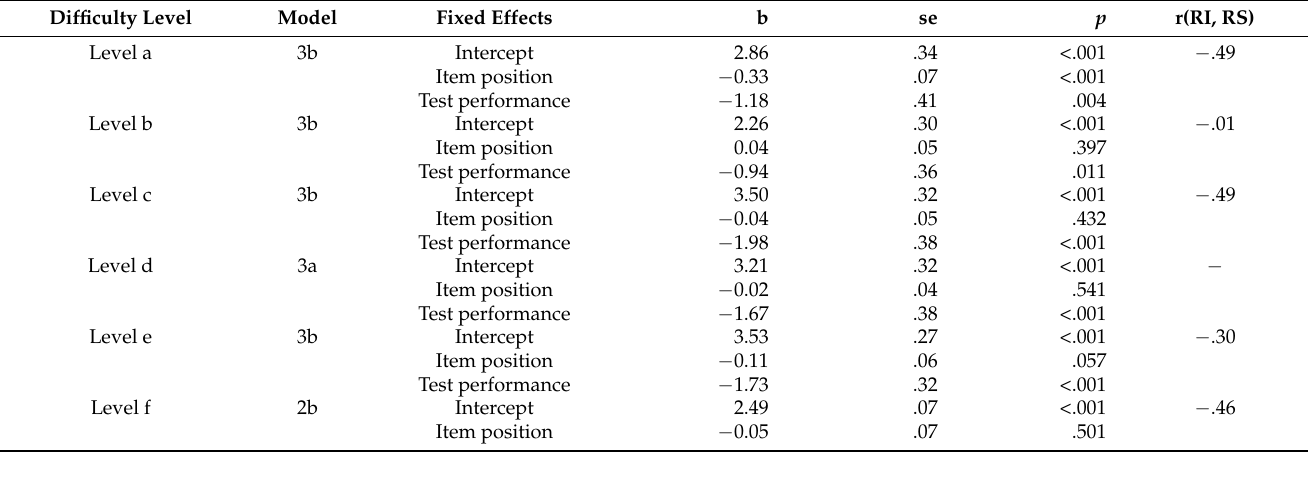
Table 5. Fixed effects and correlations between random intercept (RI) and random slope (RS) of the MLM with the dependent variable confidence rating.